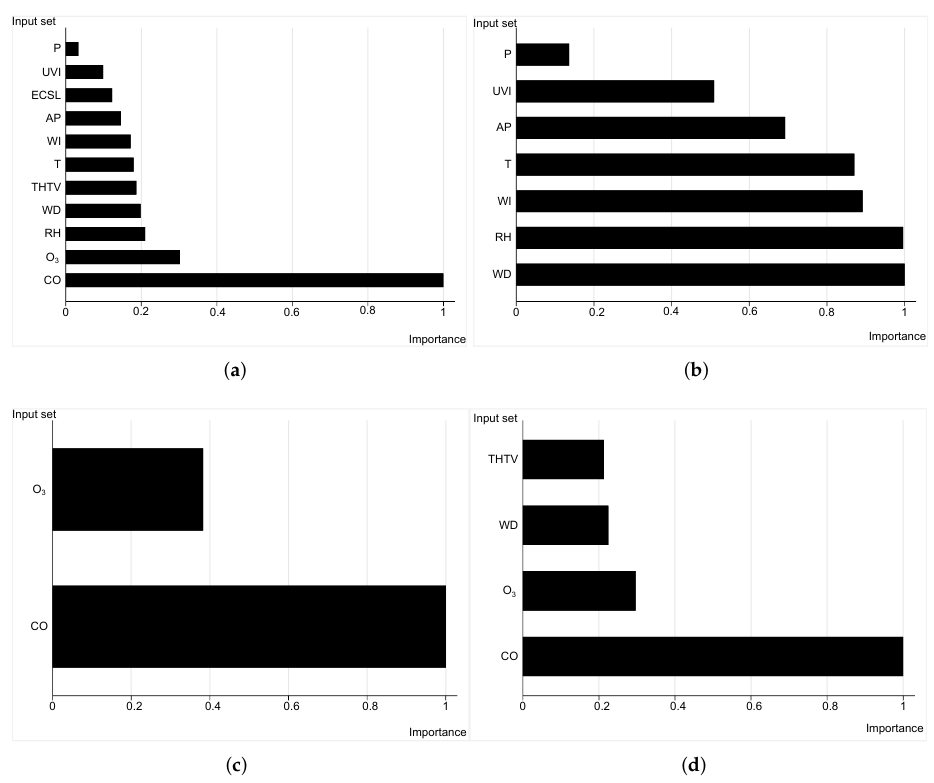
Figure 9. Variable importance analysis applied to four different scenarios. ( a ) All input variables. ( b ) Only weather inputs. ( c ) Only significant air pollutants. ( d ) Only significant covariates from